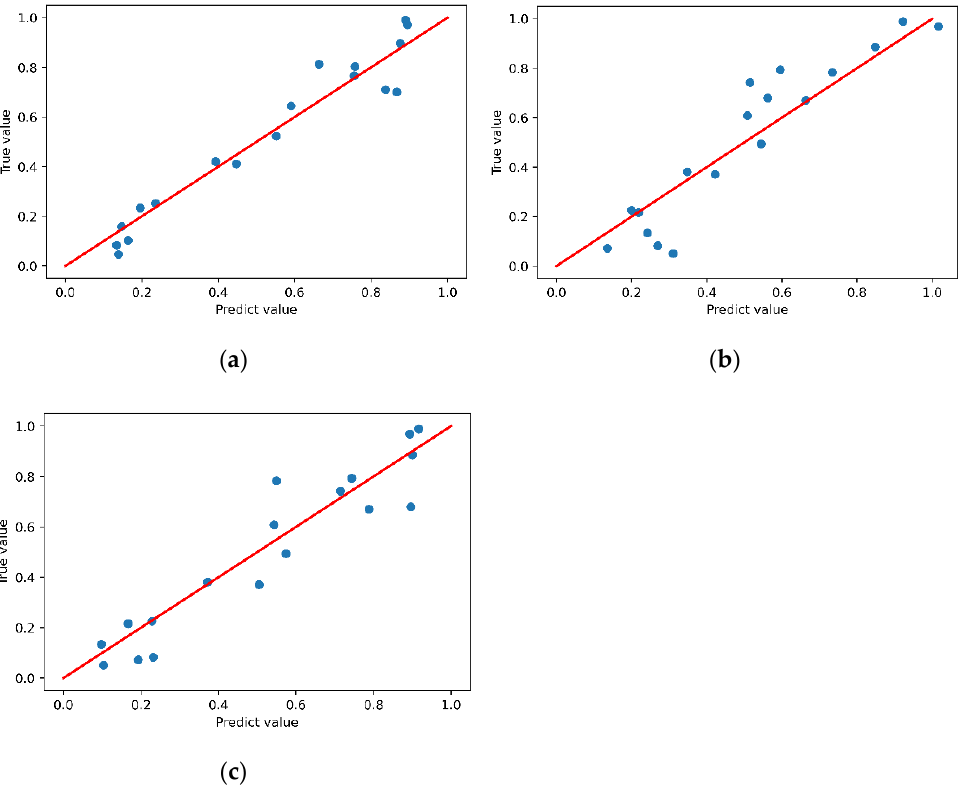
Figure 12. Validation set prediction results. ( a ) LGBM. ( b ) Densenet121. ( c ) Vision Transformer.